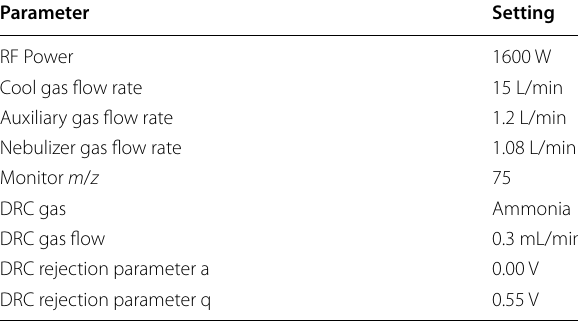
Table 2 Operating parameters of